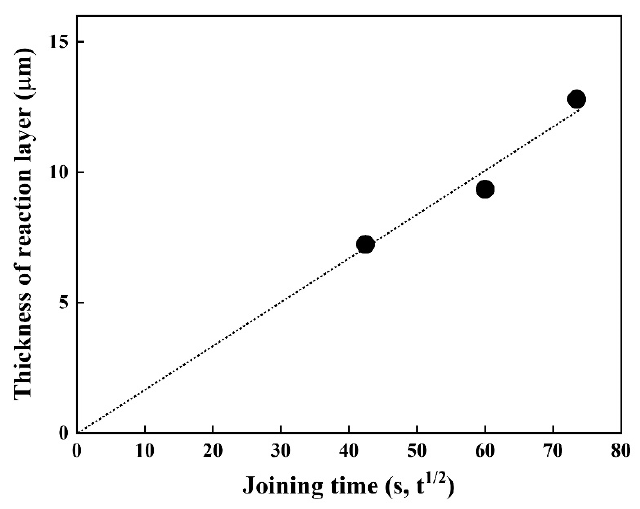
Figure 5. Thickness of the reaction layer as a function of joining time at 1023 K. Further, the temperature dependence of the reaction layer was evaluated using the materials joined at 923, 1023, 1123 K for 90 min, and the growth rate constant (m 2 ·s) was calculated. The Arrhenius plot of the growth rate constants for the reaction layer is shown in Figure 6.